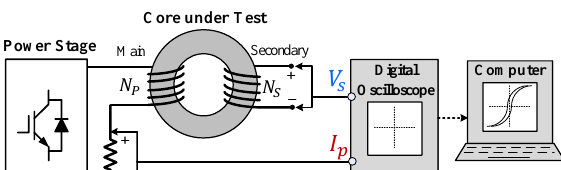
Figure 4. Schematic diagram of the test setup used to measure the B ( H )